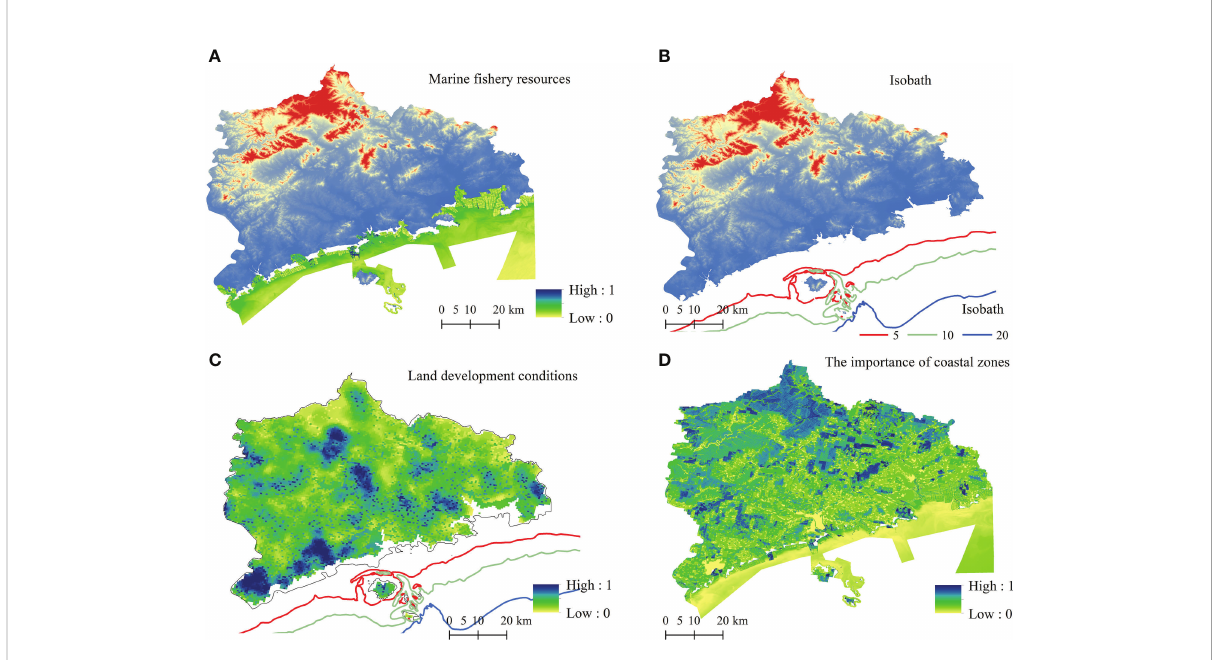
FIGURE 12 Evaluation indicators of coastline function